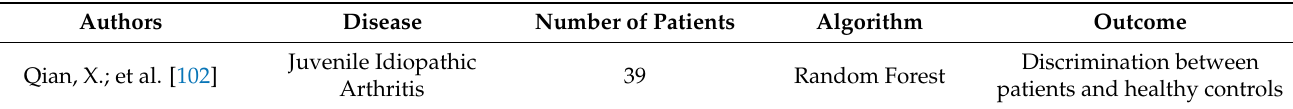
Table 2. Literature data in which AI tools is used to study the oral-gut microbiota axis of rheumatic diseases.